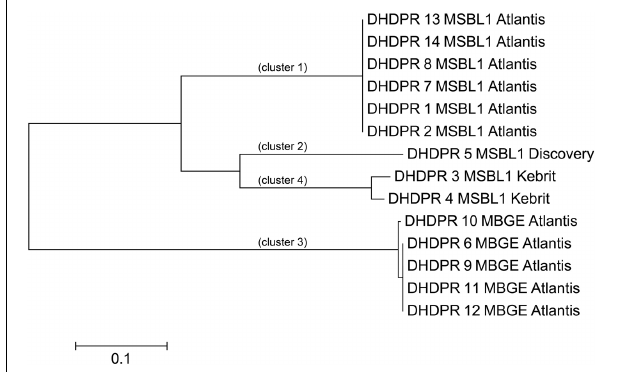
FIGURE 3 | Phylogenetic tree of the DHPR hits. To identify isoenzyme classes, every PPM set of hits was clustered into phylogenetic groups. For the 14 Dihydrodipicolinate reductases (DHPR) four closely related phylogenetic clusters were found. Scale bare: 0.1 amino acid substitutions per